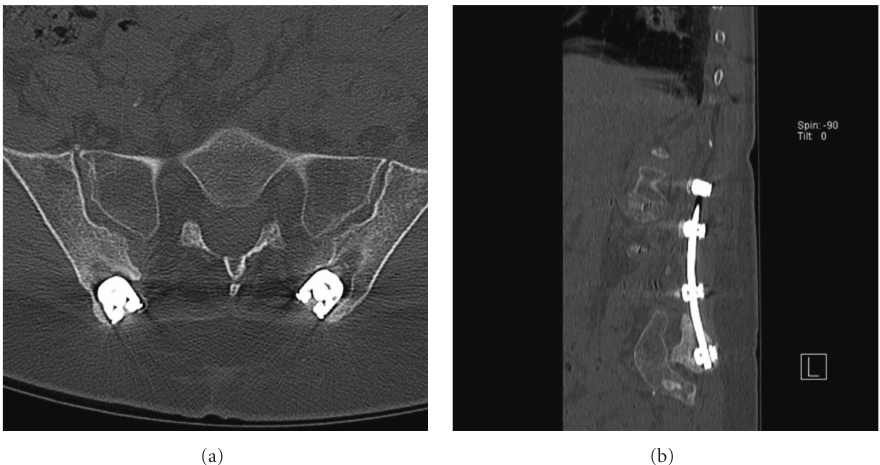
Figure 3: Recession of the iliac screw saddles into the bone to avoid hardware prominence as seen on this postoperative (a) axial and (b) sagittal reconstruction CT scan.